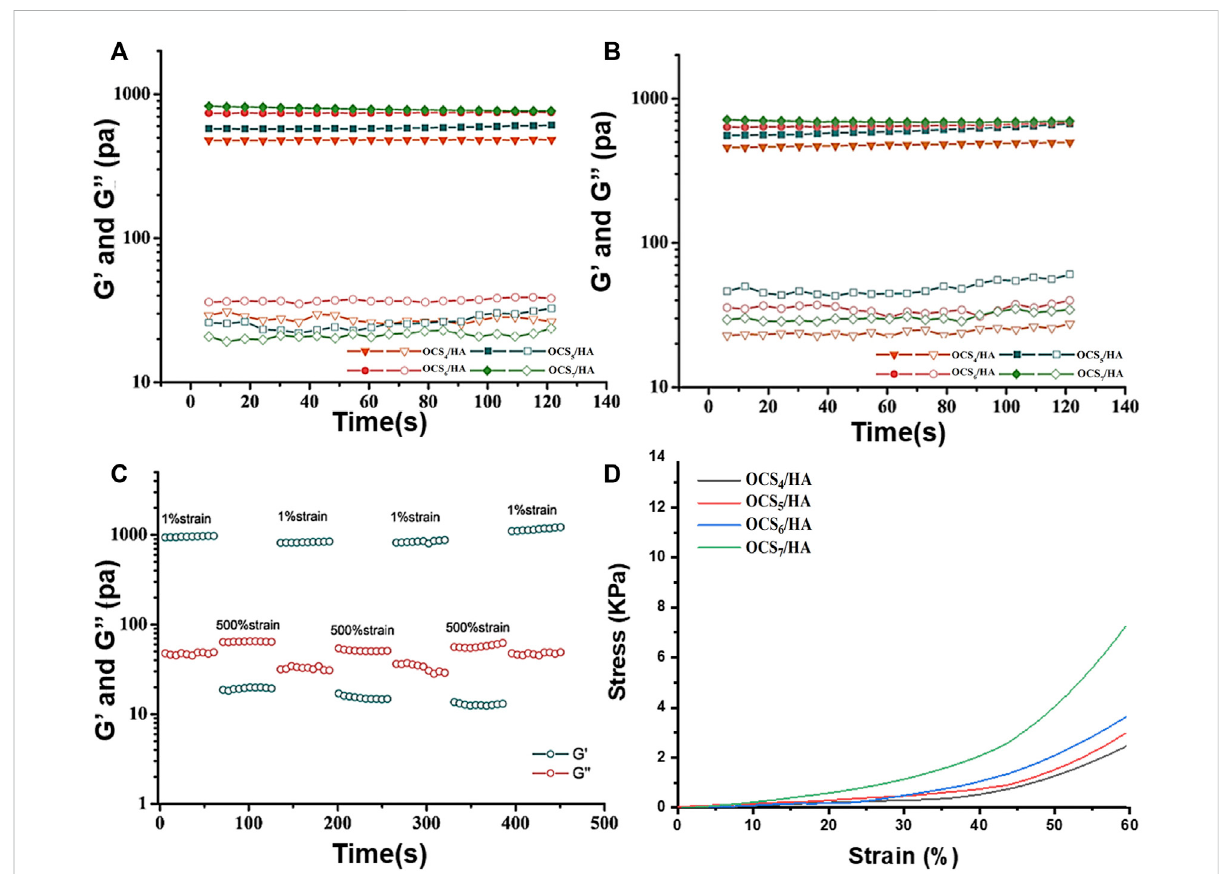
FIGURE 4 RheologicalpropertiesoftheOCS/HAhydrogels. Timesweepmeasurementsofthe (A) OCS/HAhydrogel andthe (B) OCS/HA-HClO hydrogel. (C) Alternating strain sweep of the OCS 7 /HA-HClO hydrogel with a low strain at 1% and a high strain at 500%. (D) Compressive test of the OCS/HA